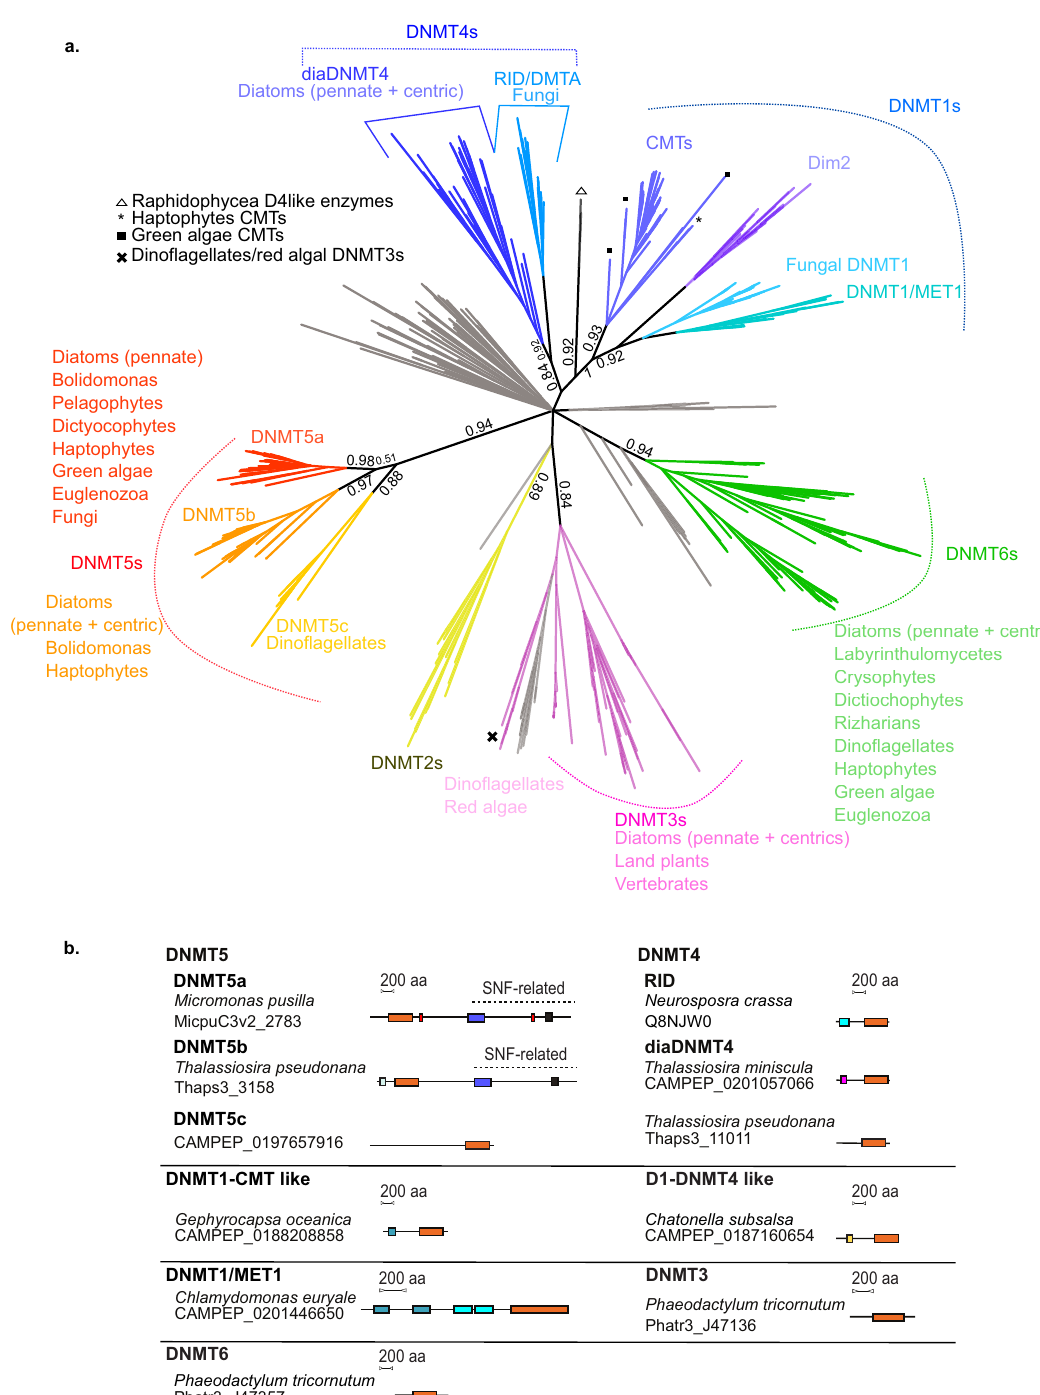
Fig. 1 Phylogenetic analysis of DNMTs from MMETSP. a Convergent phylogenetic tree of DNMT domains from the MMETSP and reference genome databases. The sequences selected were from microeukaryotes. Numbers represent MrBAYES posterior probabilities. Gray branches represent bacterial and viral DNA cytosine methyltransferase enzymes. We indicate the main lineages found within each gene family using their corresponding colors next to the tree. b Schematic representation of the DAMA/CLADE structure of representative DNMT enzymes. DNMT DNA methyltransferase; RING: Ring zinc fi nger domain, DX Dead box helicase, Hter C-terminus-Helicase, LBR Laminin B receptor, RFD Replication Foci Domain, BAH Bromo-Adjacent Homology, Chromo Chromodomain, PHD Plant